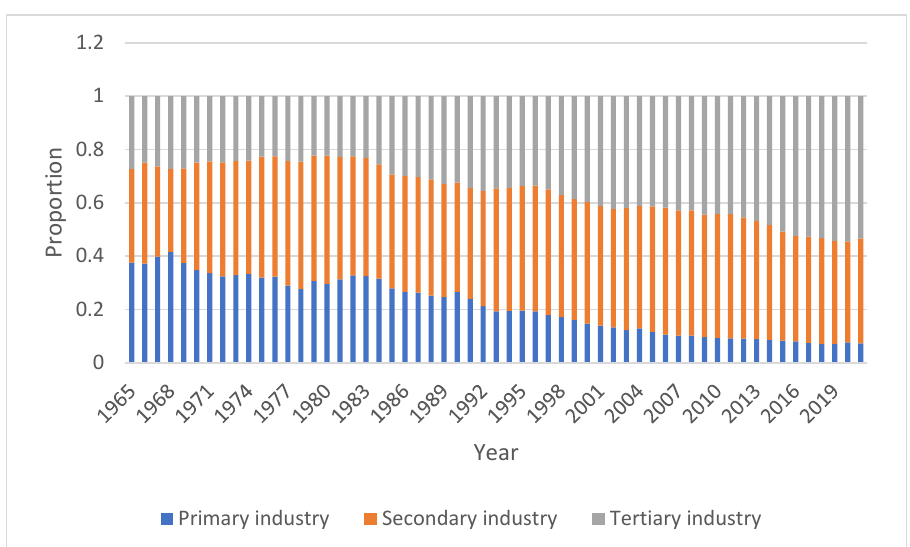
Figure 2. The proportion of primary, secondary, and tertiary industries.